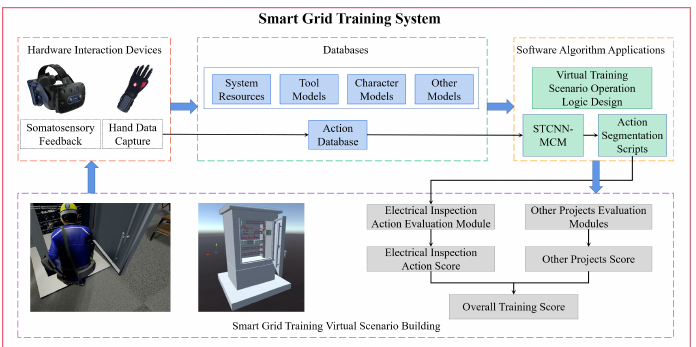
Figure 11. Smart-grid-training-system operation flow